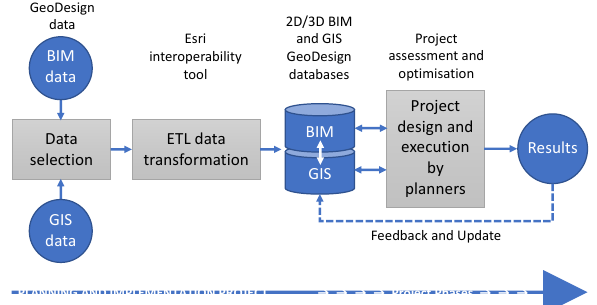
Figure 6. Concept employed by Schaller et al. (2017) for BIM/GIS data